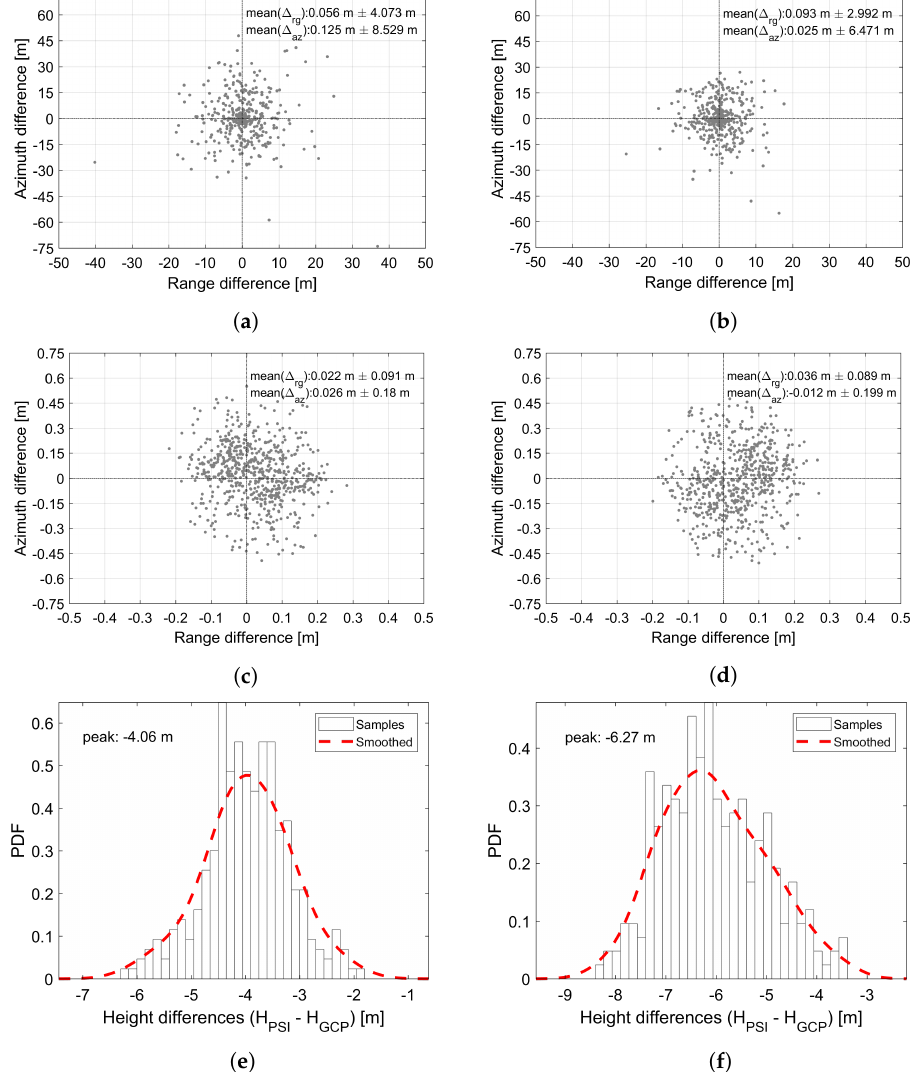
Figure 12. Restriction of the DEM error estimation to the true correspondences among GCPs and PS. ( a , b ) demonstrate the scatterplots of GCP-PS pairs before outlier removal, for Beam57 and Beam42, respectively; ( c , d ) show the scatterplots of the GCP-PS pairs after outlier removal. This causes a decrease in the bias and the standard deviation of the coordinate differences; ( e , f ) depict the robust height offset estimation after removal of the height differences in accordance with the 2 σ rule. The peak of the smoothed histogram indicates the DEM error for each beam. Note that, for all the figures, the coordinate differences are defined as the GCP coordinates subtracted from their corresponding PS